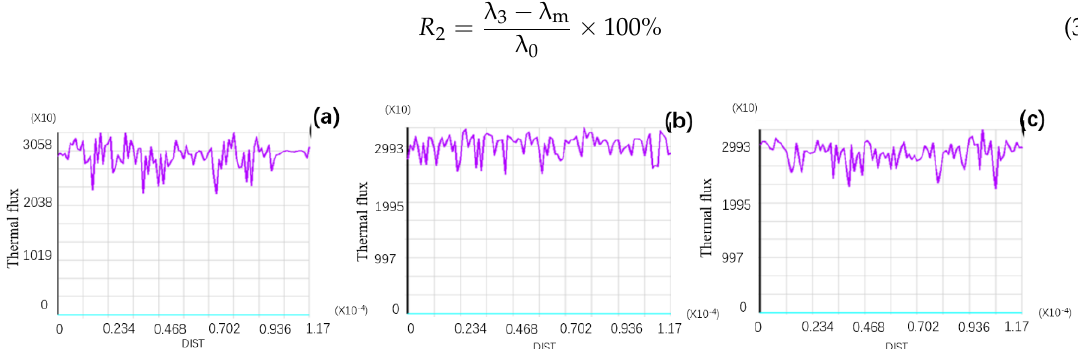
Figure 8. Distributions of thermal flux on the materials without monoclinic phase ( a ) M 1 , ( b ) M 2 and ( c ) M 3 .